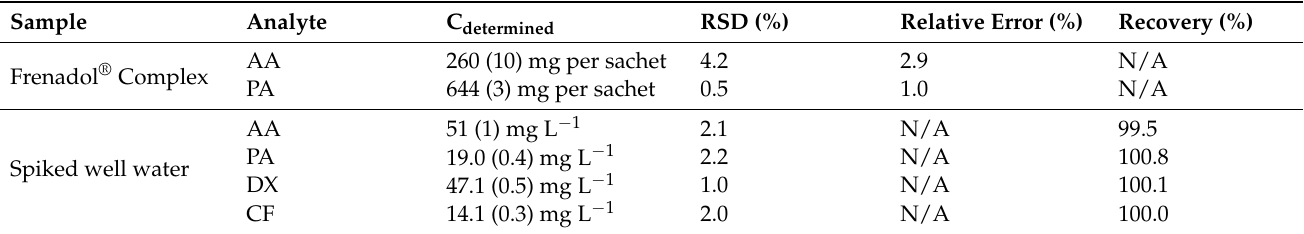
Table 3. Determination of target analytes in Frenadol ® Complex drug and in spiked well water by DPV on SPCE by standard addition calibration method.